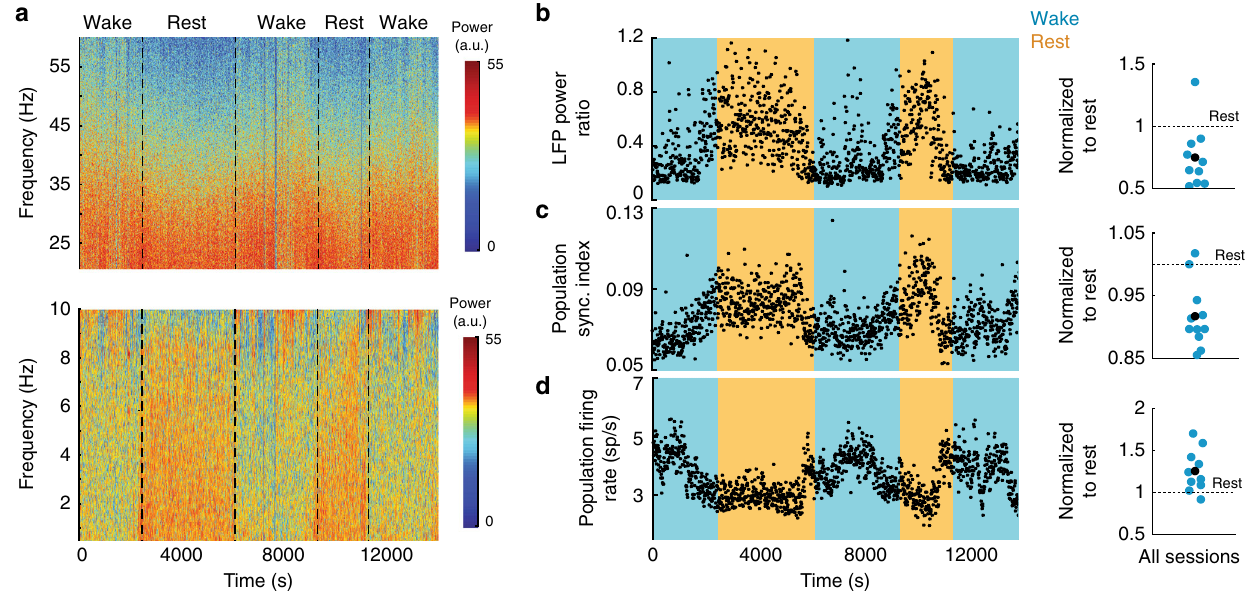
Fig. 2 Natural rest produces widespread changes in cortical dynamics. a Spectral analysis of LFPs recorded on the microelectrode array. (Top) High- frequency (20 – 60 Hz) LFP spectrogram, showing a reduction in power of high-frequency oscillations during rest. (Bottom) Low-frequency (0.5 – 10 Hz) LFP spectrogram, showing an increase in power of low-frequency oscillations during rest. b (Left) LFP synchrony is quanti fi ed as the ratio of low to high- frequency LFP power. LFP power ratio is increased during rest. (Right) Summary for all sessions showing LFP power ratio during wake normalized to rest. LFP power ratio during wake is signi fi cantly lower than during rest ( p = 0.027, two-sided Wilcoxon signed-rank, n = 11 sessions). On average, LFP power ratio during wake is 75% from that of rest. c (Left) PSI is increased during rest. (Right) Summary for all sessions showing PSI during wake normalized to PSI during rest. PSI during wake is signi fi cantly lower than during rest ( p = 0.0049, two-sided Wilcoxon signed-rank, n = 11 sessions). On average, the PSI during wake is 91% that of rest. d (Left) Population fi ring rate is reduced during rest. (Right) Summary of all sessions showing average population fi ring rate during wakefulness normalized to rest. Population fi ring rate during wake is signi fi cantly higher than during rest ( p = 0.0029, two-sided Wilcoxon signed- rank, n = 11 sessions). On average, the population fi ring rate during wakefulness is 26% higher than during